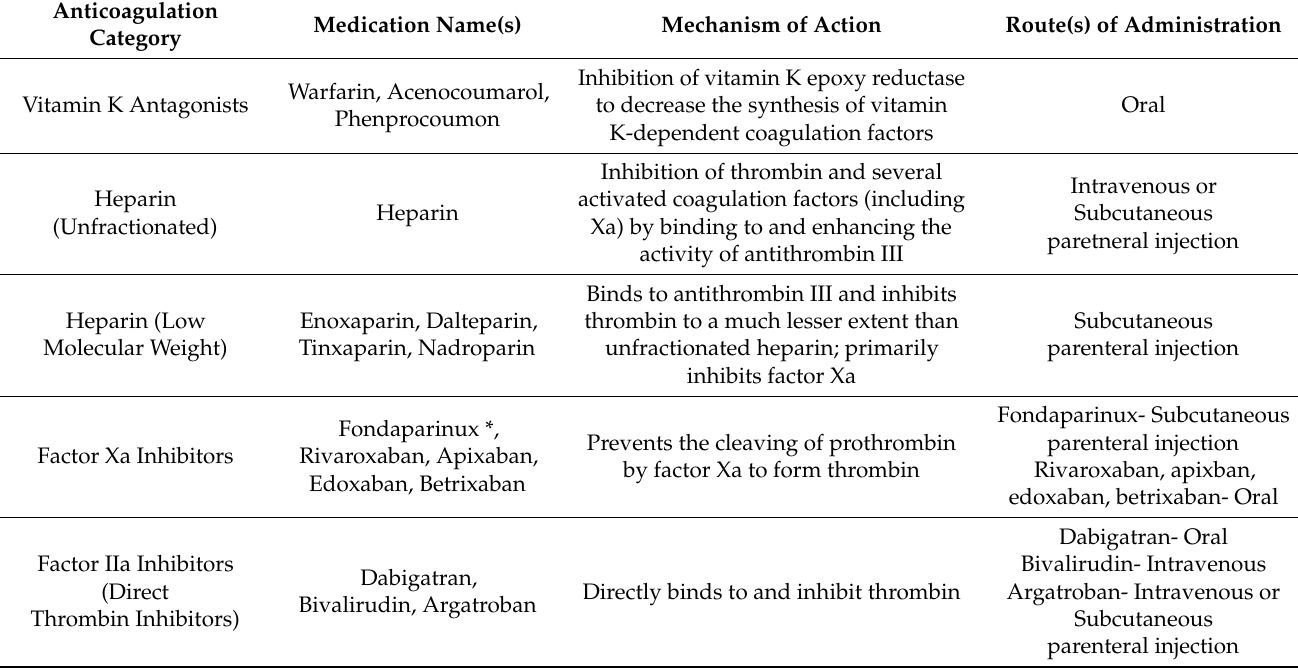
Table 1. Anticoagulants categorized by mechanism of